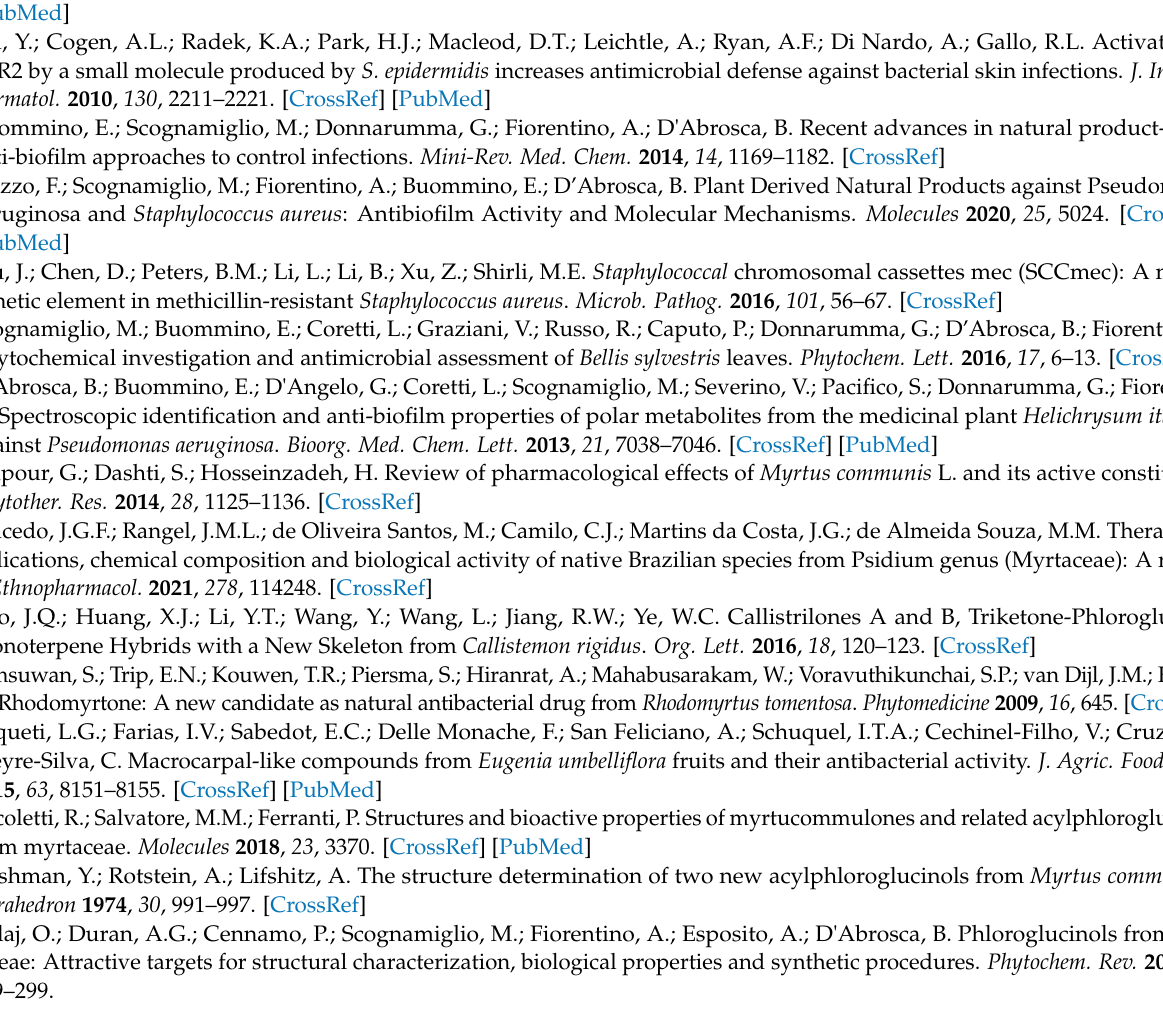
compound 1 and 2 mixture. Figure S4: HSQC and 1 H-NMR spectra of compounds 1 and 2 mixture. Figure S5: HMBC and 1 H-NMR spectra of compounds 1 and 2 mixture; Figure S6: 1 H-NMR spectrum of compound 4